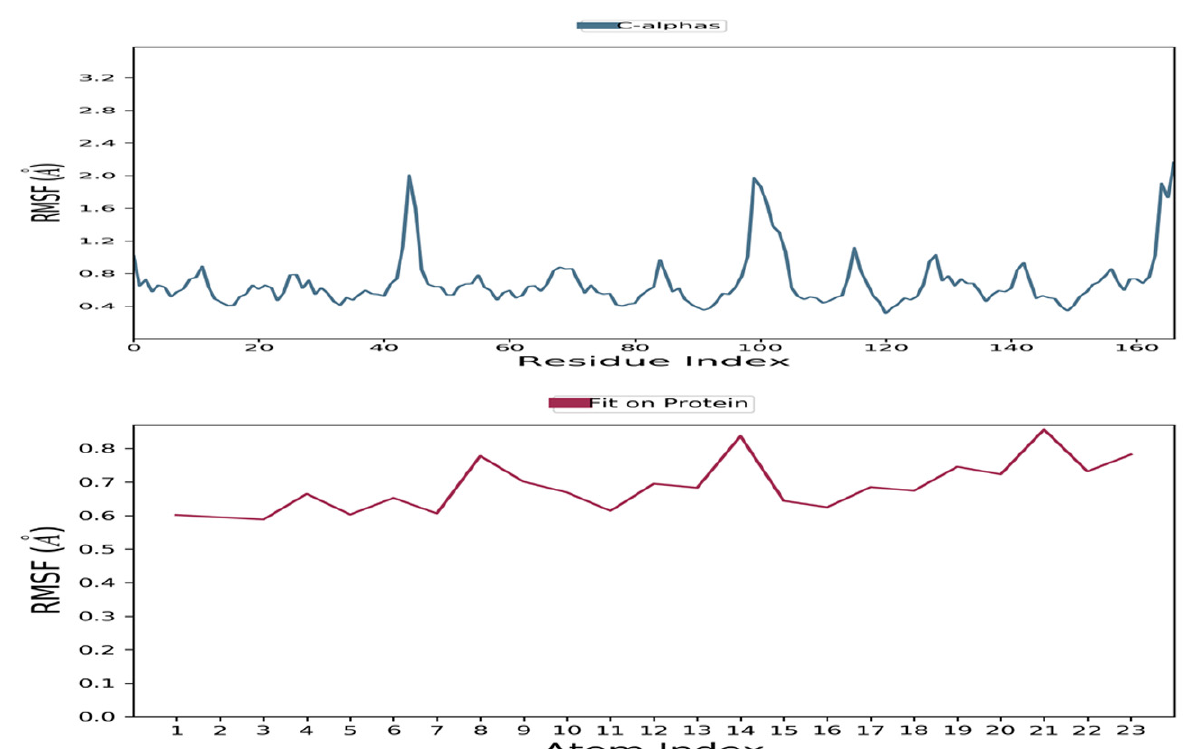
Figure 5. RMSF values of the monomeric subunit of the viral ARP protein of SARS-CoV-2 and complexed guggulsterone recorded during the MD simulation for 100 ns.